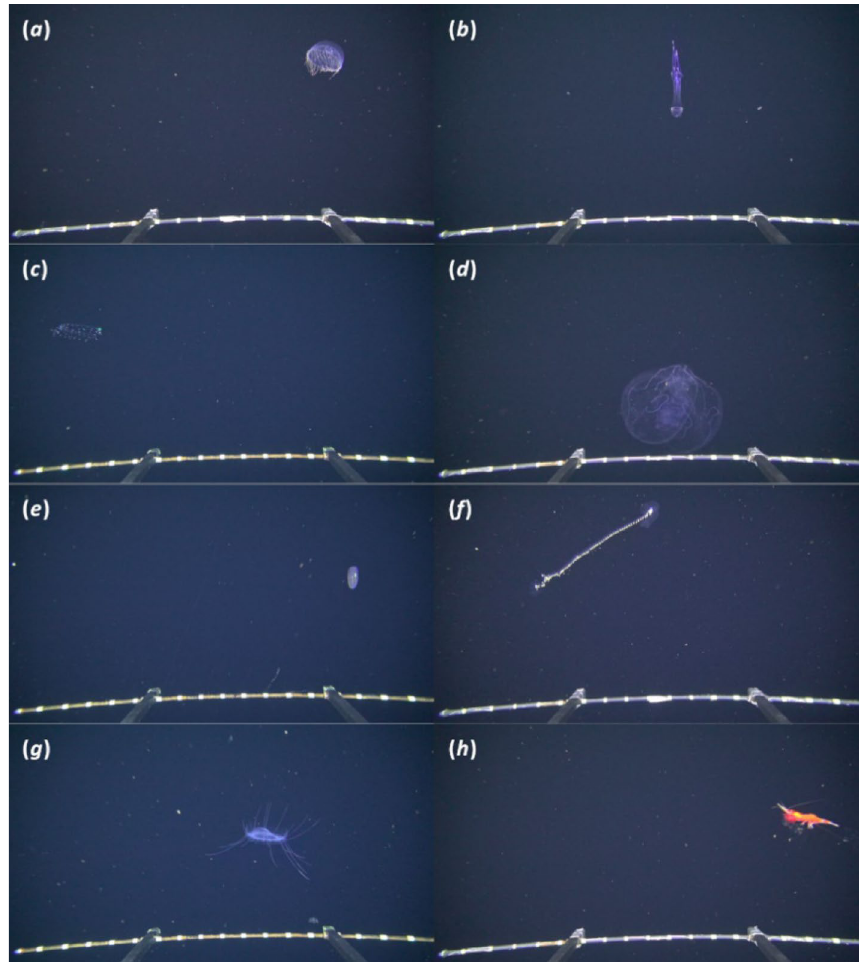
Figure 3. Examples of macrozooplankton as observed by PELAGIOS during MSM49 in the Cape Verde region. Organisms with peak abundances within the OMZ are ( a ) Halitrephes sp. 50 , ( b ) Colobonema sp., ( c ) Lilyopsis sp. and ( d ) Thalassocalyce inconstans . ( e ) Beroe sp. with a bimodal vertical distribution pattern. ( f ) Praya , a siphonophore with a distribution above the OMZ. ( g ) Solmissus sp. with a wide vertical distribution and a peak in the OMZ. ( h ) A decapod crustacean, a group of organisms that showed vertical migration. The distance between the white stripes on the bar at the bottom of the images is 5